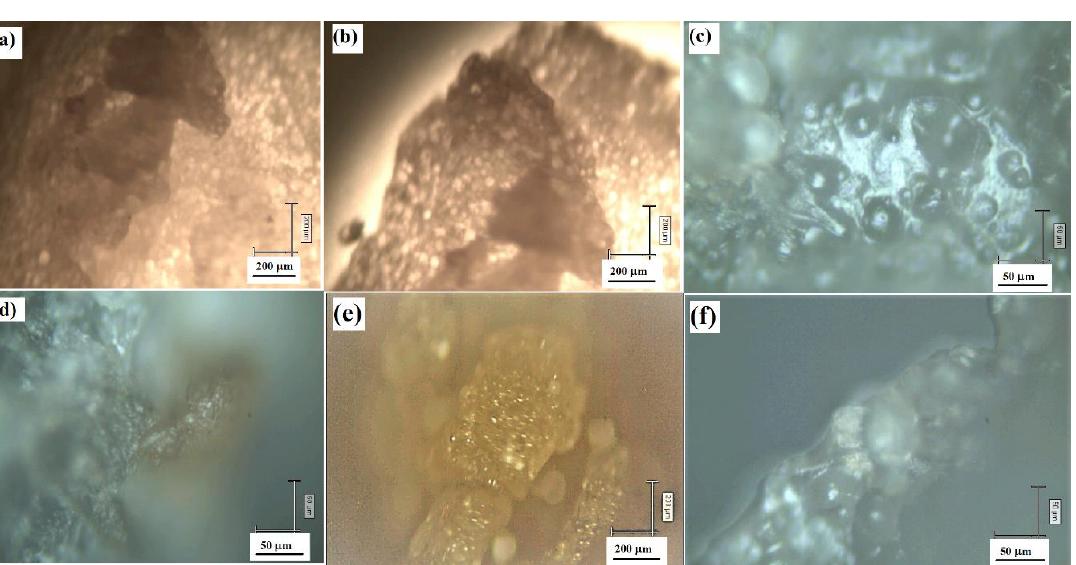
Figure 9. Micrographs corresponding to multiple acquisition performed on different sites on the surface of synovial fluid, showing embedded lipid droplets: ( a ) center, ( b )